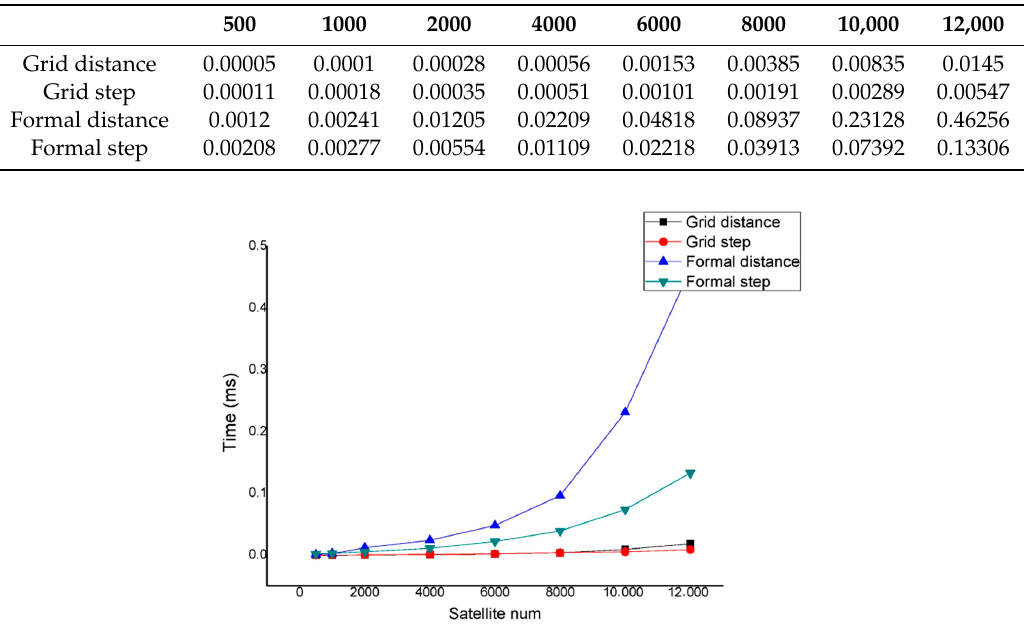
Figure 11. Comparison of route planning.